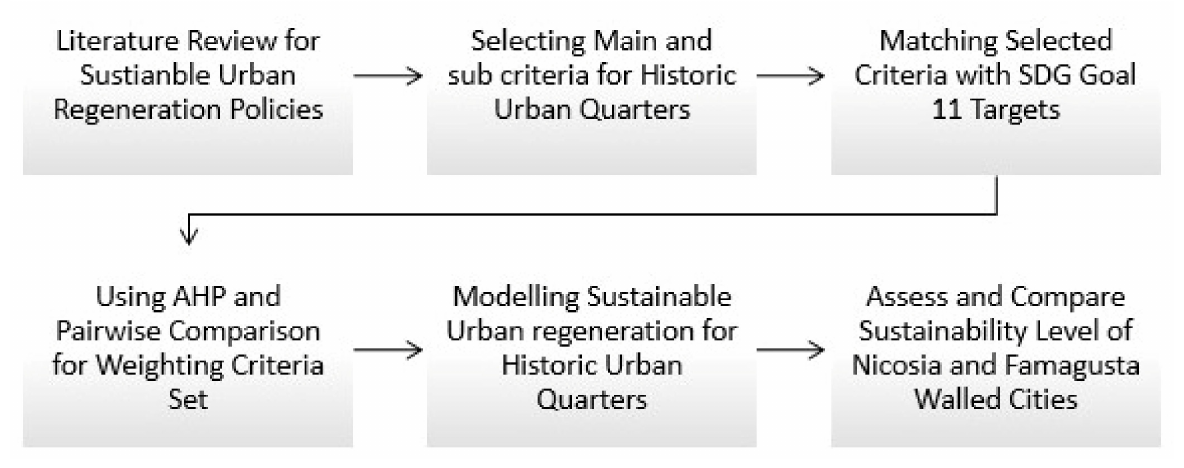
Figure 1. United Nations’ Sustainable Development Goals.